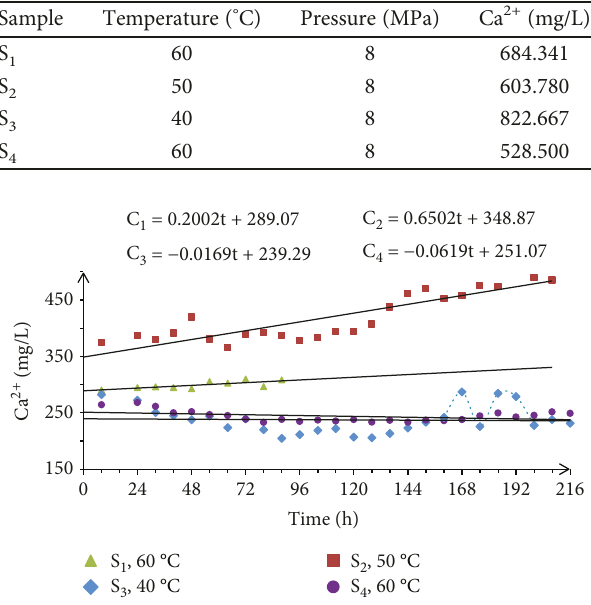
Table 3: The calcite solubility of the carbonate samples under the CFDE experimental conditions.